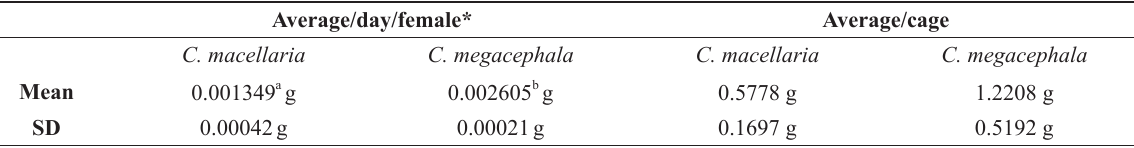
Comparison of egg mass weight of Cochliomyia macellaria and Chrysomya megacephala .